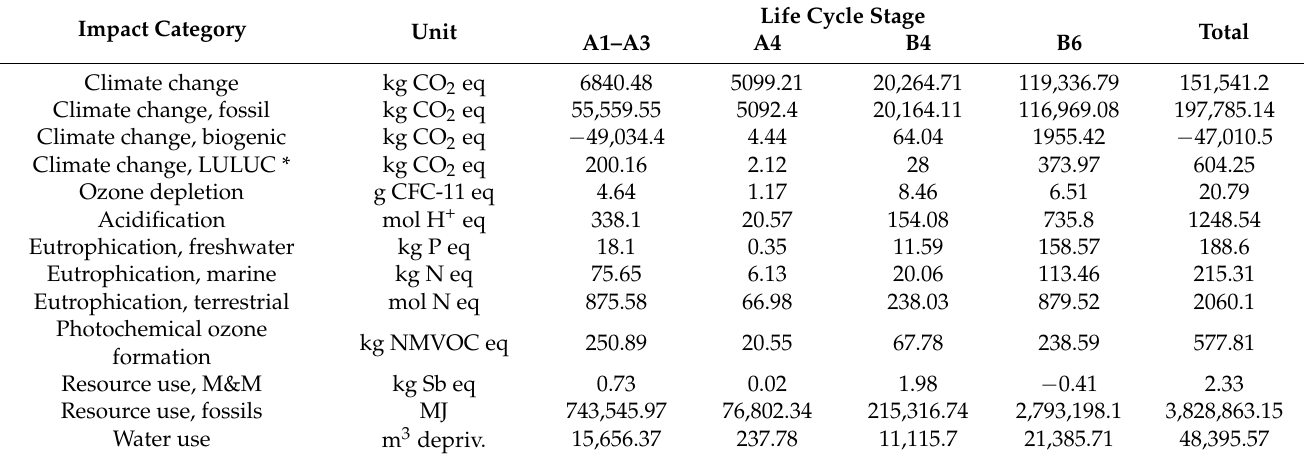
Table 3. Impact assessment of selected building life cycle stages regarding photovoltaic energy export.